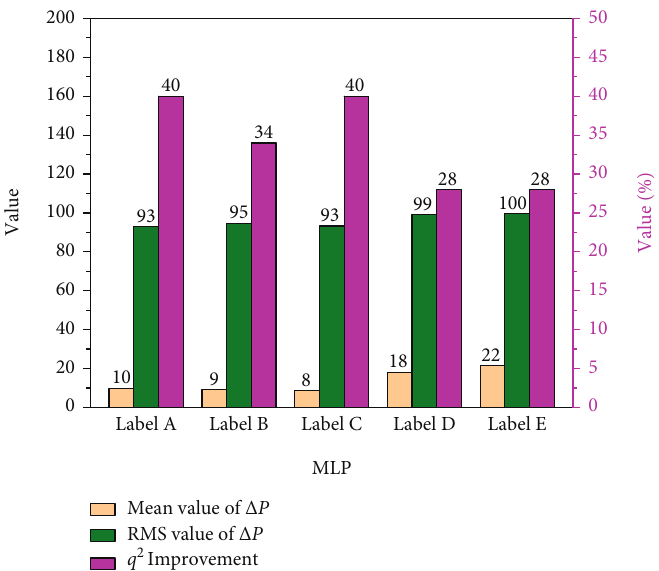
! j and 1/sin ð θ